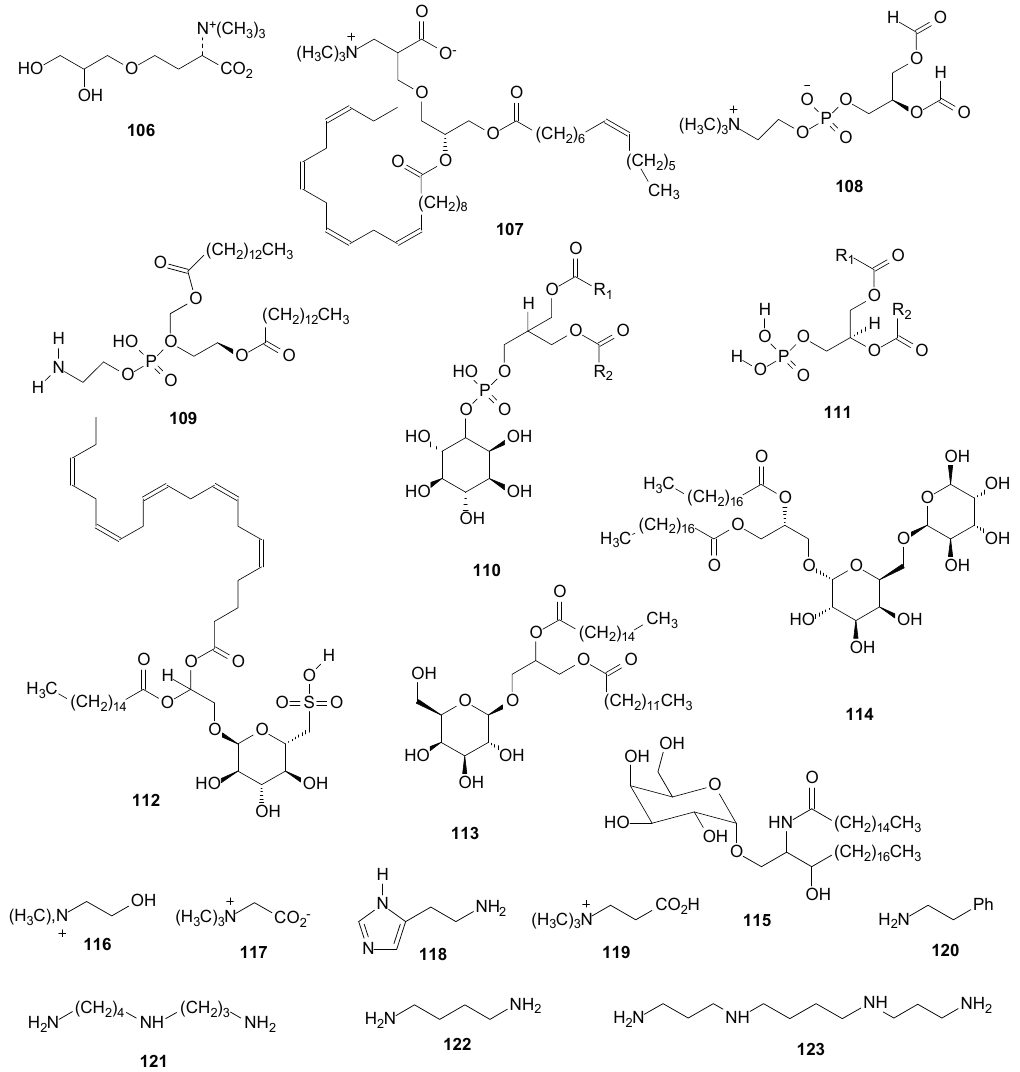
Figure 8. Chemical structures of other compounds: lipids and amines from Ramalina species of lichenized